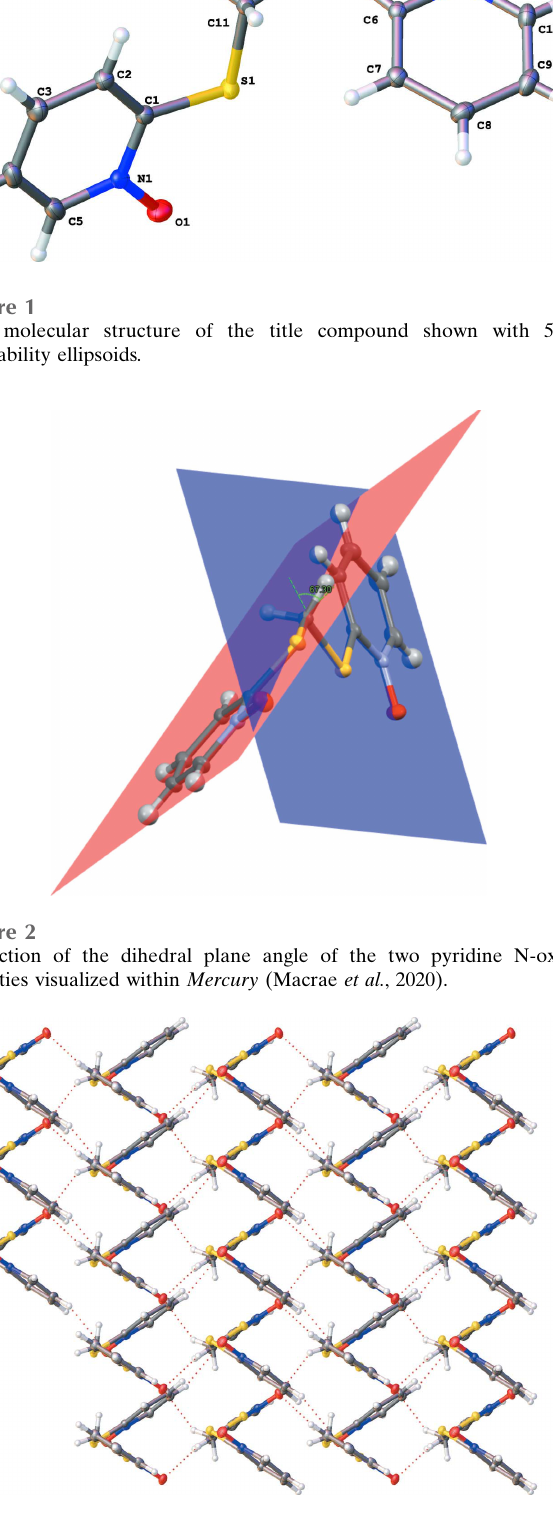
Figure 3 Packing diagram for the title compound as viewed from the [101] direction. Dotted red lines depict the weak hydrogen bonds.